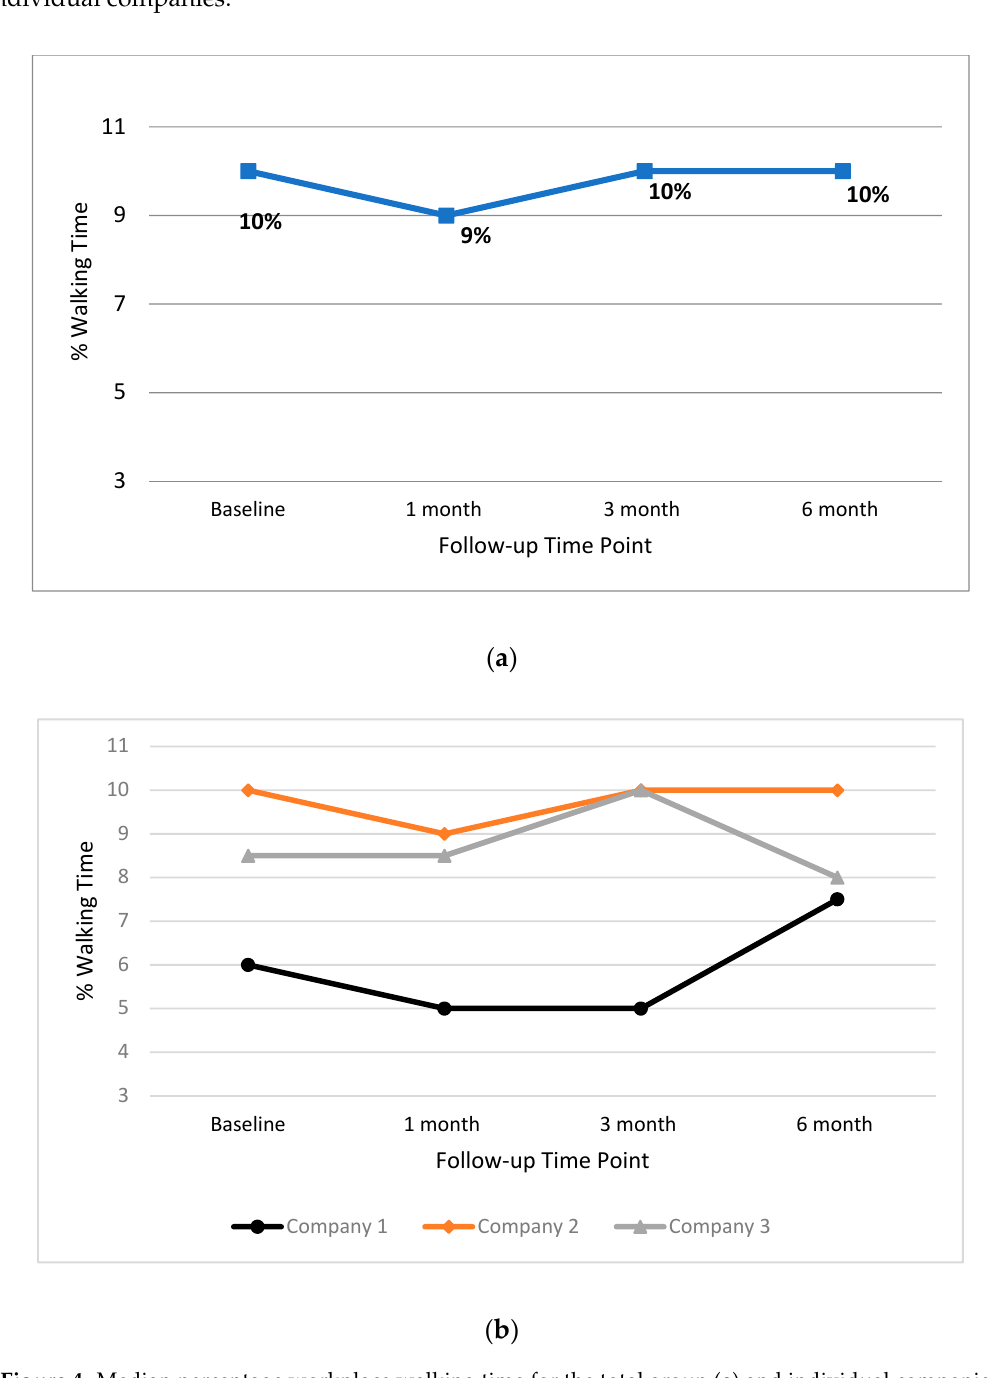
Figure 4. Median percentage workplace walking time for the total group ( a ) and individual companies ( b ) at baseline, one month, three month and six month time points.